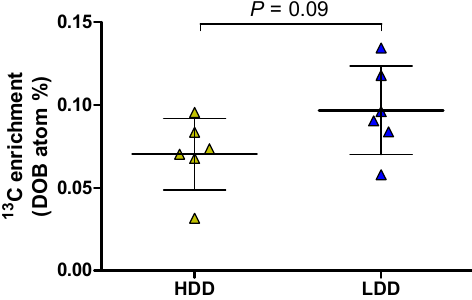
Figure 5. Total 13 C enrichment in liver tissue from HDD and LDD females 4 h after oral administration of a 13 C-labelled starch bolus in PW 4. Data ( n = 6) is expressed relative to females that did not receive the 13 C starch bolus ( n = 3) and presented as mean and SD. Student’s t -test. DOB, delta over baseline; HDD, highly digestible-starch diet; LDD, lowly digestible-starch diet; PW, post-weaning week.